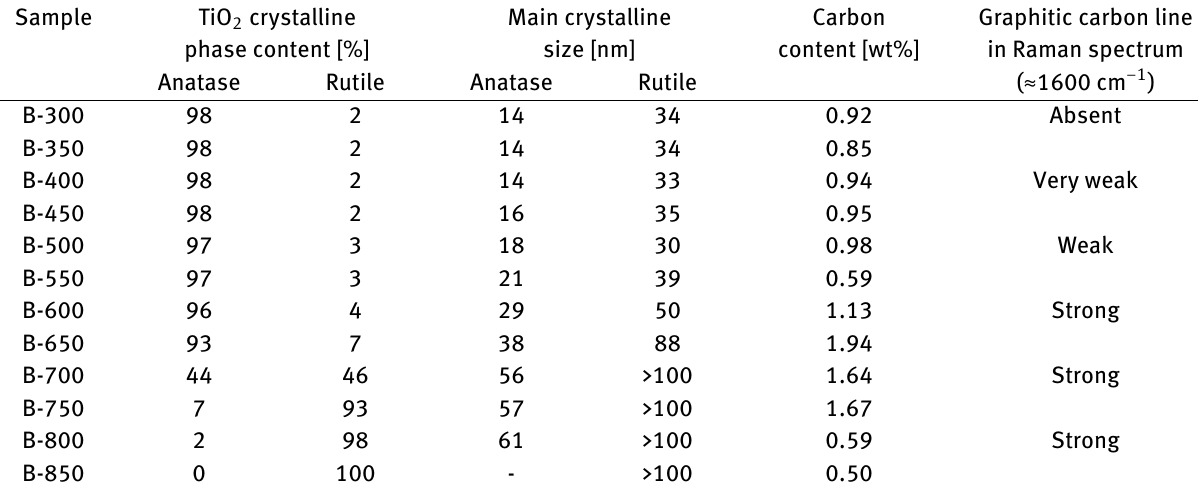
Table 1: XRD phase composition, main crystallite size and the intensity of graphitic carbon line in Raman spectrum. Sample TiO 2 crystalline Main crystalline Carbon Graphitic carbon line